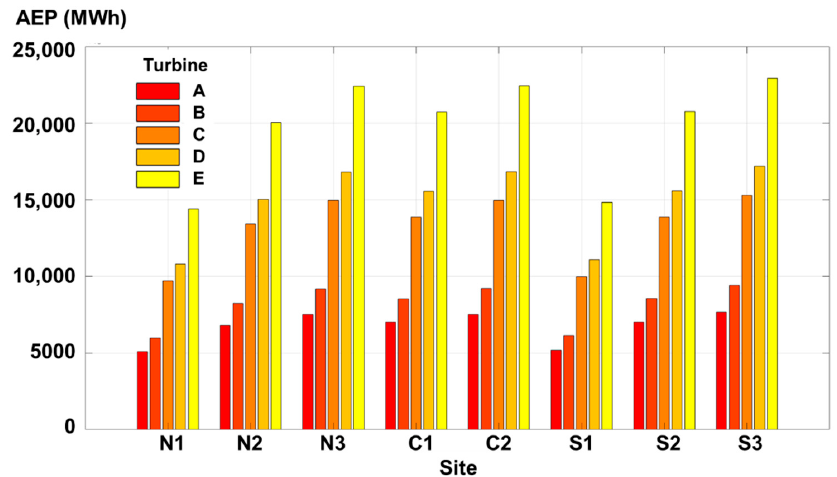
Figure 10. Annual electricity production (MWh) corresponding to the full time distribution.